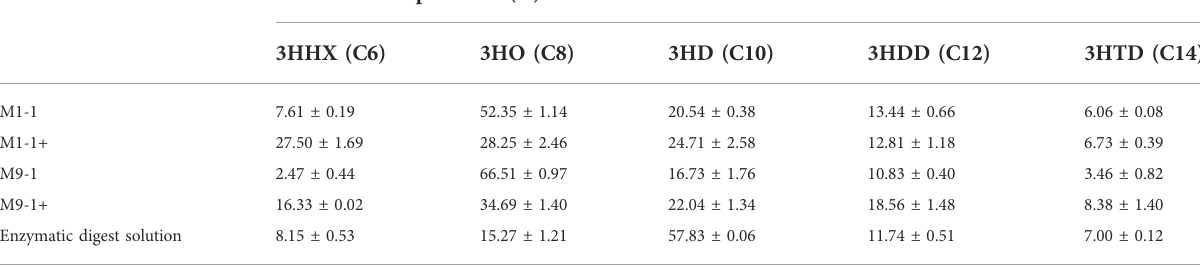
TABLE 1 The monomer compositions of mcl-PHA produced by the microbial consortium using from lignocellulosic hydrolysate. Strains